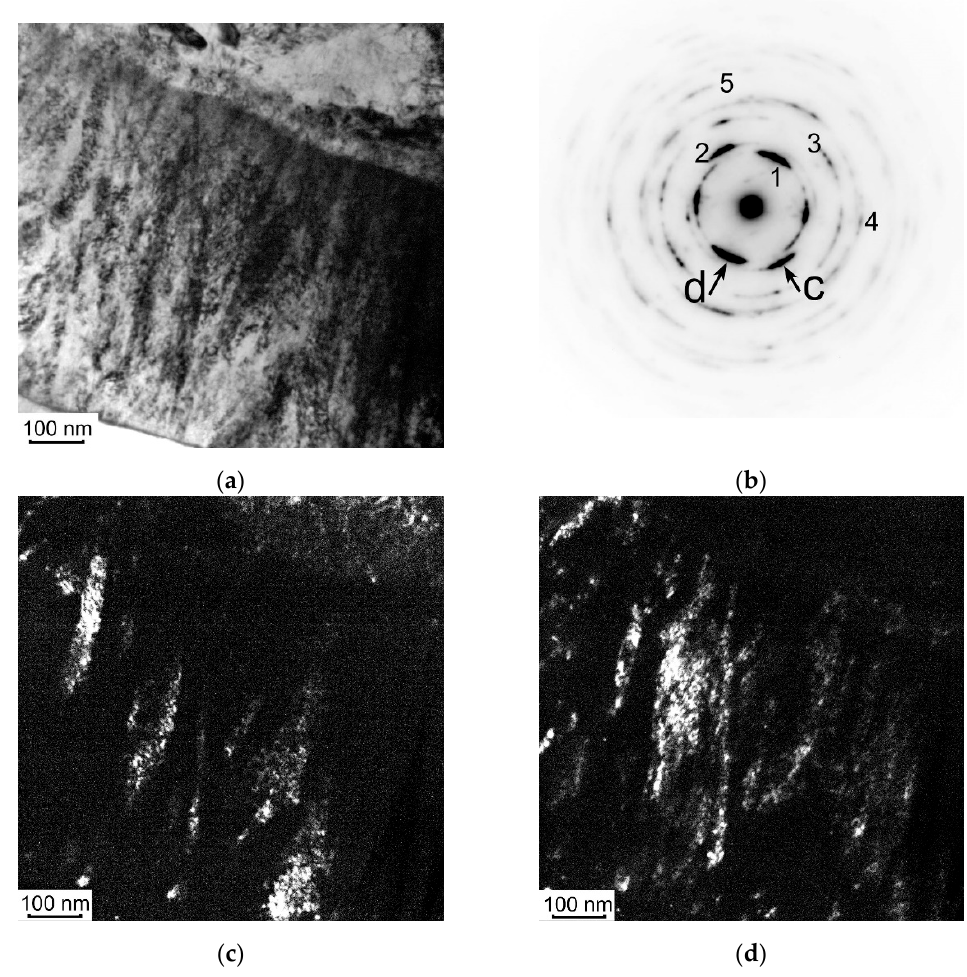
Figure 4. Bright-field ( a ) image (TEM) of the (Ti,Zr)N coating microstructure from the TZ3M specimen; microdiffraction pattern ( b ) from the central coating area (reflections of the following types are indicated: 1—(111), 2—(200), 3—(220), 4—(311), 5—(400)); dark-field images ( c , d ) of the coating microstructure (reflections of the (200) and (111) types are indicated in Figure 4b by